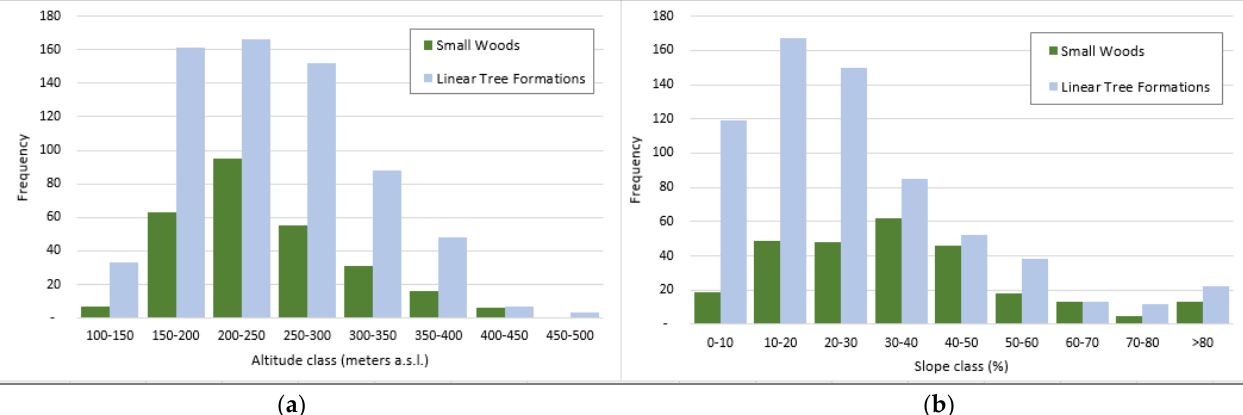
Figure 3. Map of the distances of agricultural and urban areas from TOF NON A/U or from forests. Table 3. Distance analysis of each point of the agricultural and urban surface from a TOF NON A/U or from a forest patch, considering and not considering TOF NON A/U. If all TOF NON A/U would be converted into agricultural areas, the distance would increase significantly, highlighting the im- portant ecological role of TOF NON A/U for the connectivity of big forest patches.